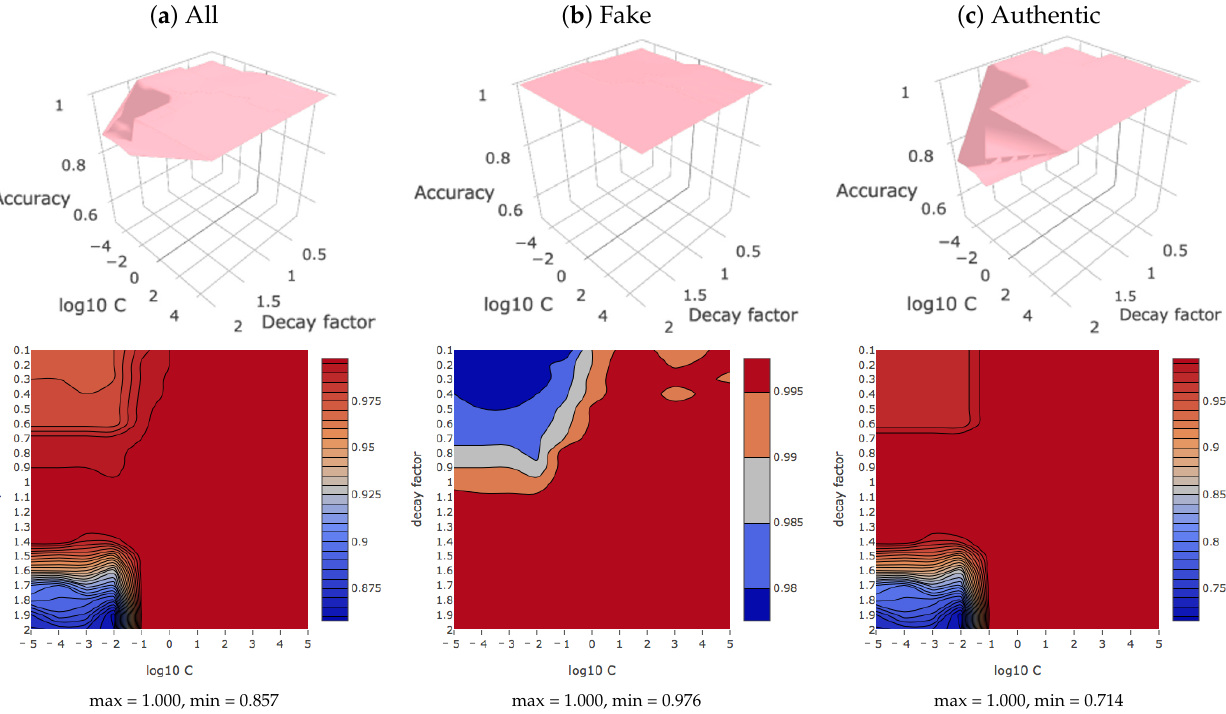
Figure 16. Five-fold cross validation scores for the training dataset of size 1000. In a wide area, the score is as high as